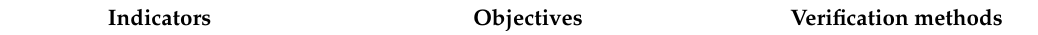
Table 1. Selected indicators for the analysis of omissions in public policy associated to